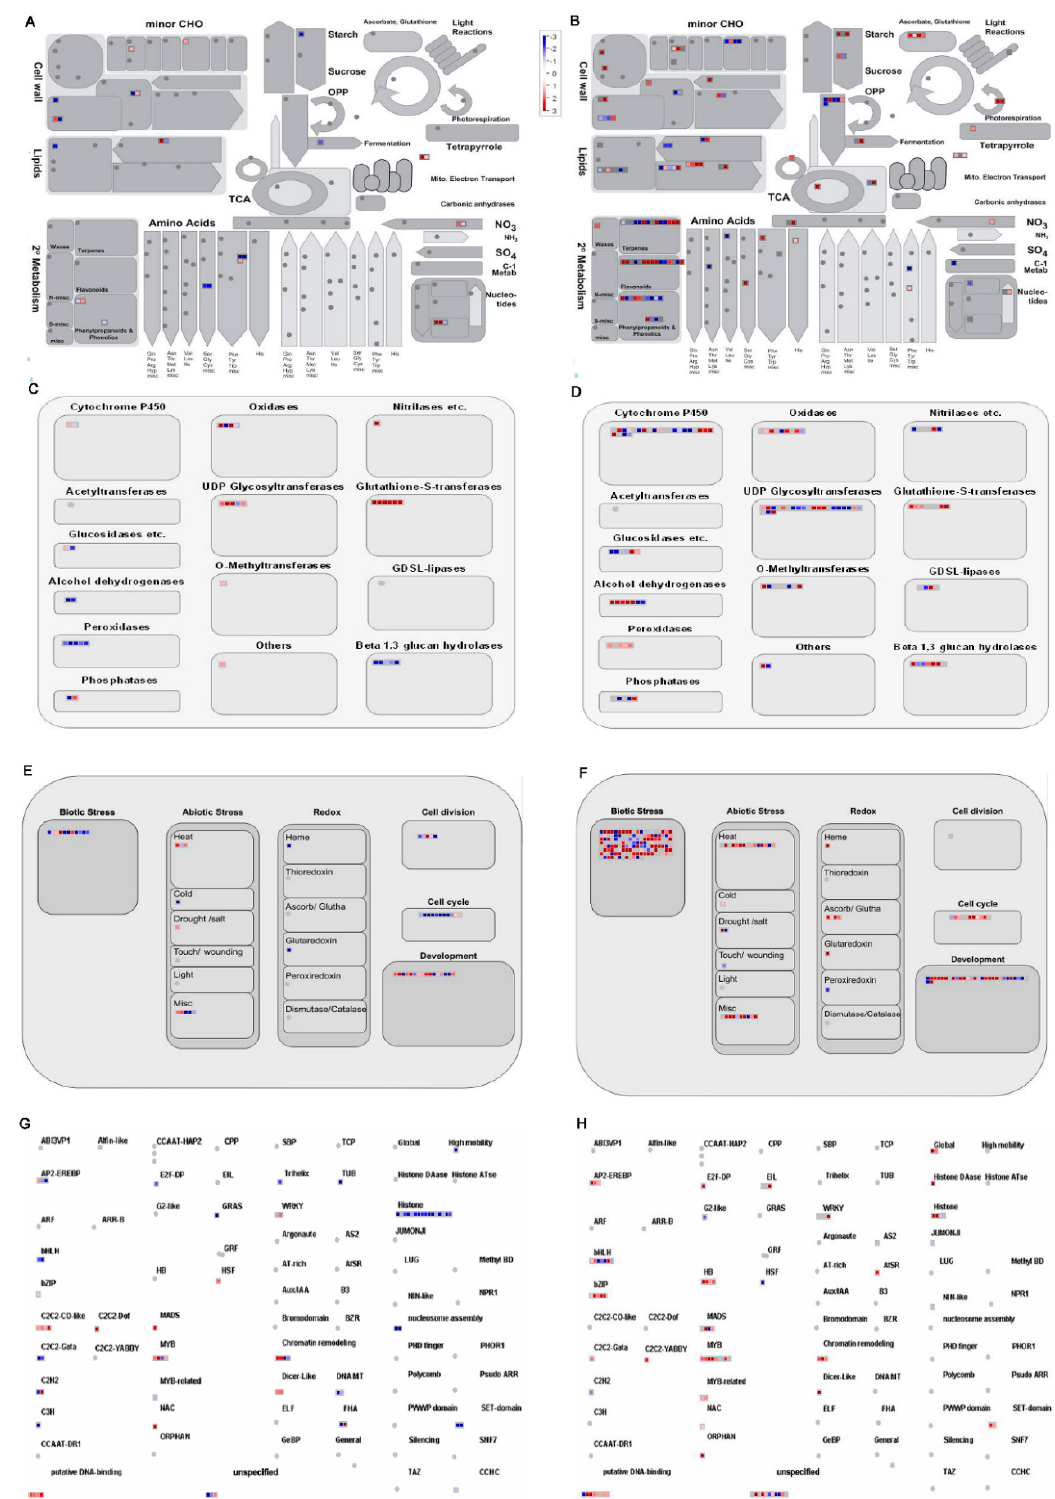
Figure 6. MapMan analysis of DEGs in irradiation response ( A , C , E , G ) and cultivar effect ( B , D , F , H ). Results of mapping 552 and 2350 genes to metabolism ( A , B ), large enzyme families ( C , D ), cellular response ( E , F ) and transcriptions ( G , H ). Red boxes, up-regulated genes; blue boxes, down-regulated genes.